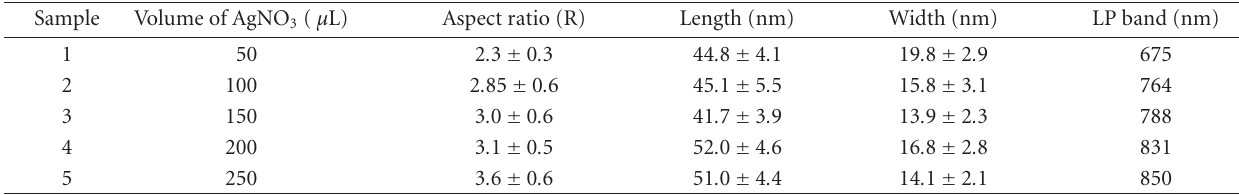
Table 1: Mean aspect ratios, lengths, widths, and longitudinal plasmon peaks for nanorods synthesized using the silver-assisted growth